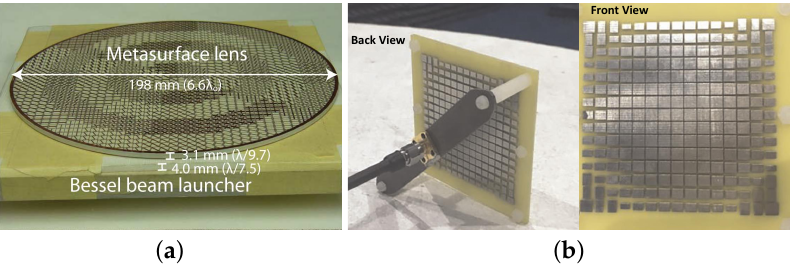
Fig. 3. Experimental setup of the circular polarizing lens placed on top of the Besselbeamlauncher.A4-mm-thickRohacell31HFfoamspacerseparatesthe Bessel beam launcher and the metasurface lens. Figure 5. Metasurface for high-gain antennas. ( a ) A circularly polarized metasurface lens placed on top of the Bessel beam launcher [147]. ( b ) PGM based high gain lens antenna